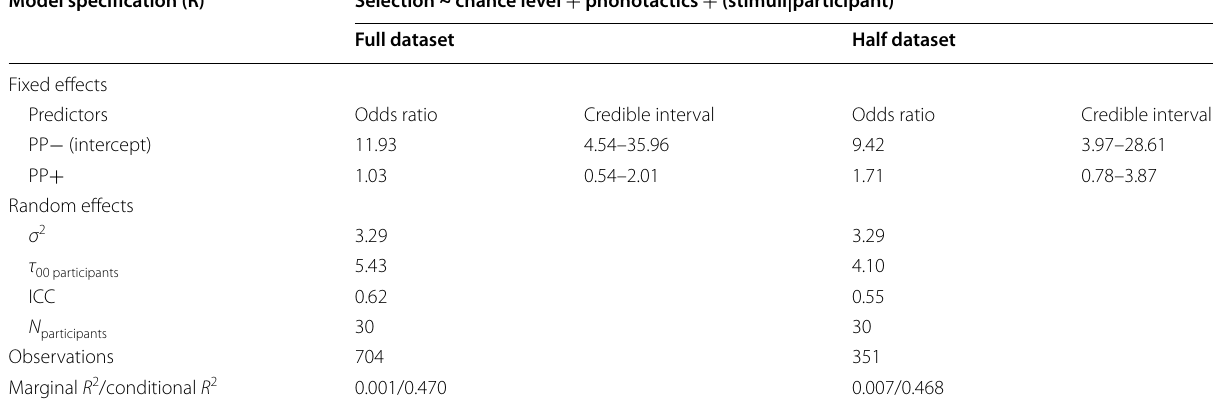
Table 3 Fixed and random effects and specifications for Bayesian models Model specification